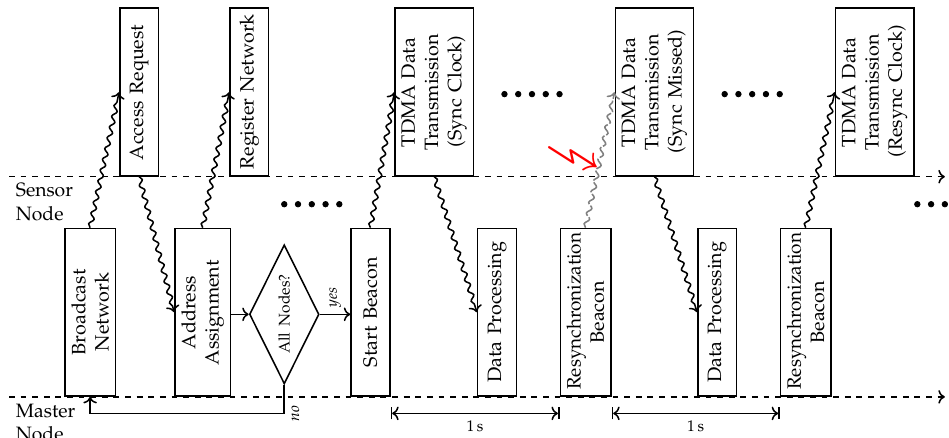
Figure 3. Timing diagram according to the communication procedure between the master node (MN) and sensor node (SN) including initialization routine and standard data acquisition